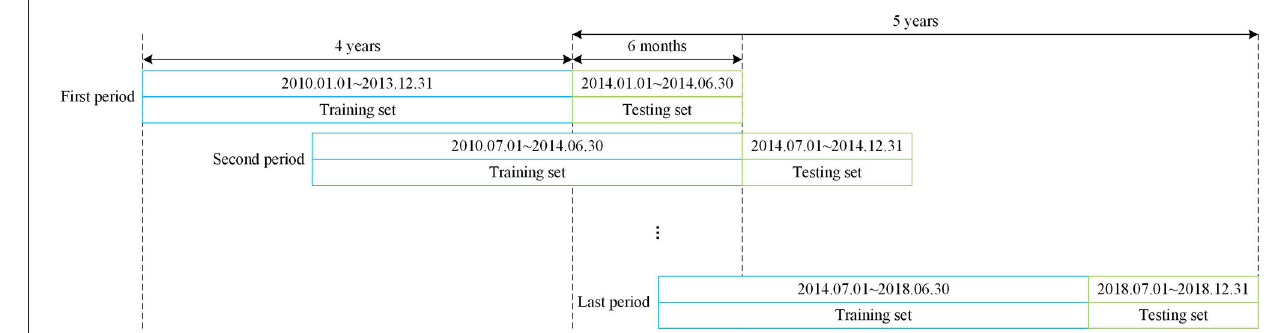
FIGURE 7 | Arrangement for training and testing sets during the whole sample